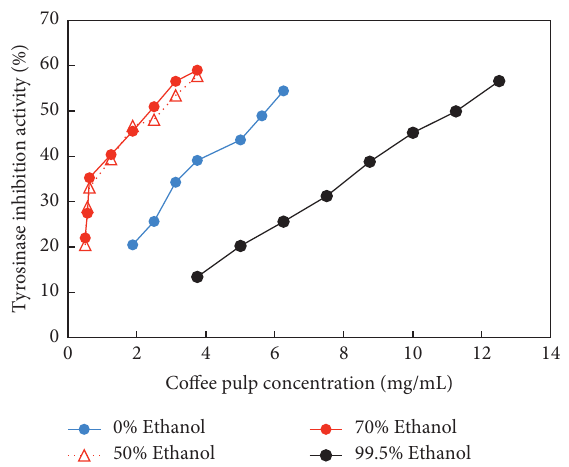
Figure 7: Tyrosinase inhibition capacity of the coffee pulp extracts obtained using different ethanol